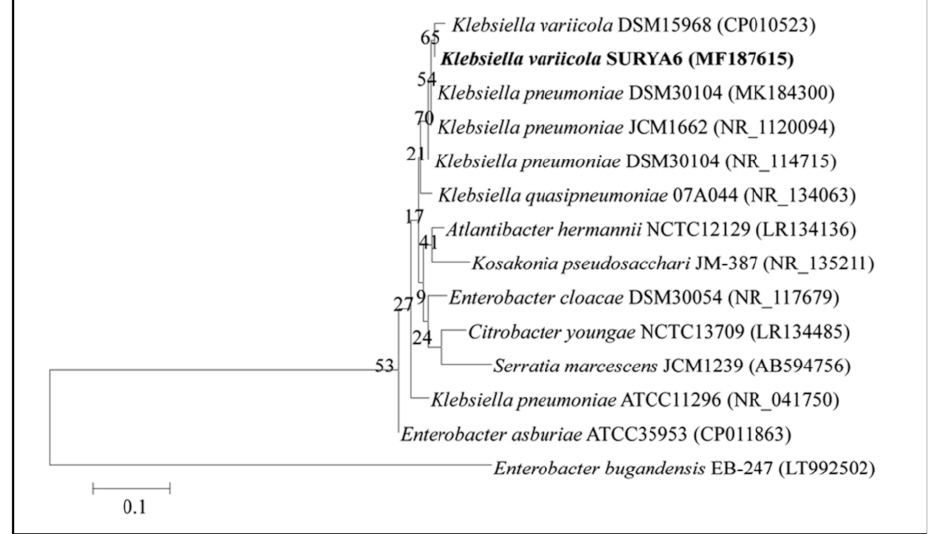
Figure 5. A phylogenetic tree showing the relatedness of the isolate N6 to other members of Genus Klebsiella. The 16S rRNA gene was amplified on PCR followed by electrophoresis. Amplified sequences were identified using the National Center for Biotechnology Information (NCBI) database and a phylogenetic tree was